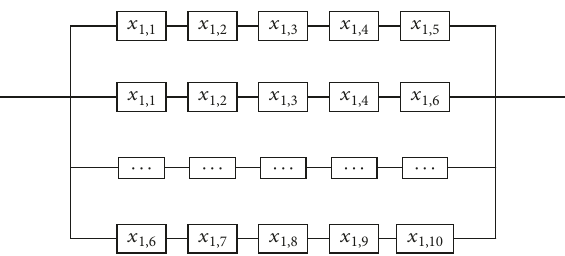
Figure 4: Block diagram of software component of network module 𝑀 𝑁,1 .